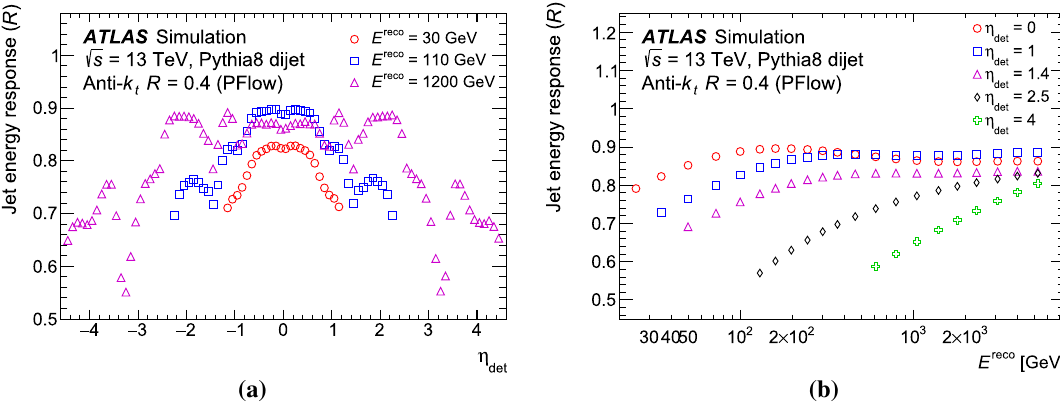
Fig. 5 The average energy response as a function of reconstructed jet a η det and b energy E reco . Each value is obtained from the corresponding parameterized function derived with the Pythia 8 MC sample and only jets satisfying p T > 20 GeV are shown